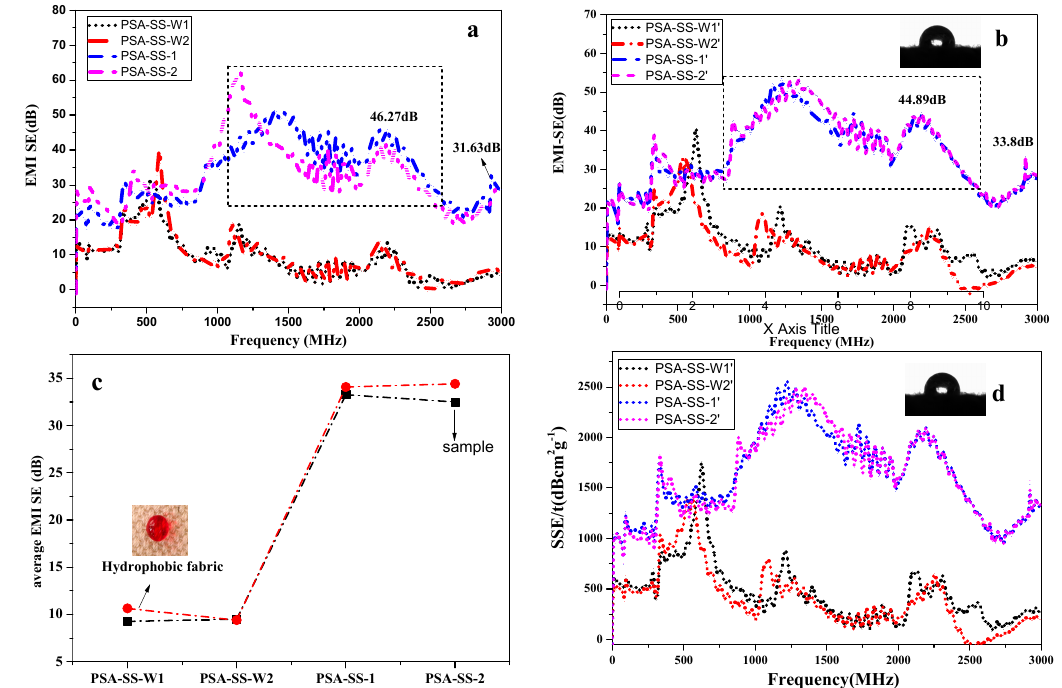
Figure 5. ( a ) The electromagnetic interference shielding effectiveness (EMI SE) of four fabrics without hydrophobic treatment; ( b ) the EMI SE of four fabrics with hydrophobic treatment; ( c ) The average EMI SE value of samples before and after hydrophobic treatment; ( d ) the shielding effectiveness per unit volume (SSE) values of hydrophobic fabrics. Table 2. The shielding effectiveness per unit volume ( SSE) and SSE/t of four types of fabrics. Fabric Type